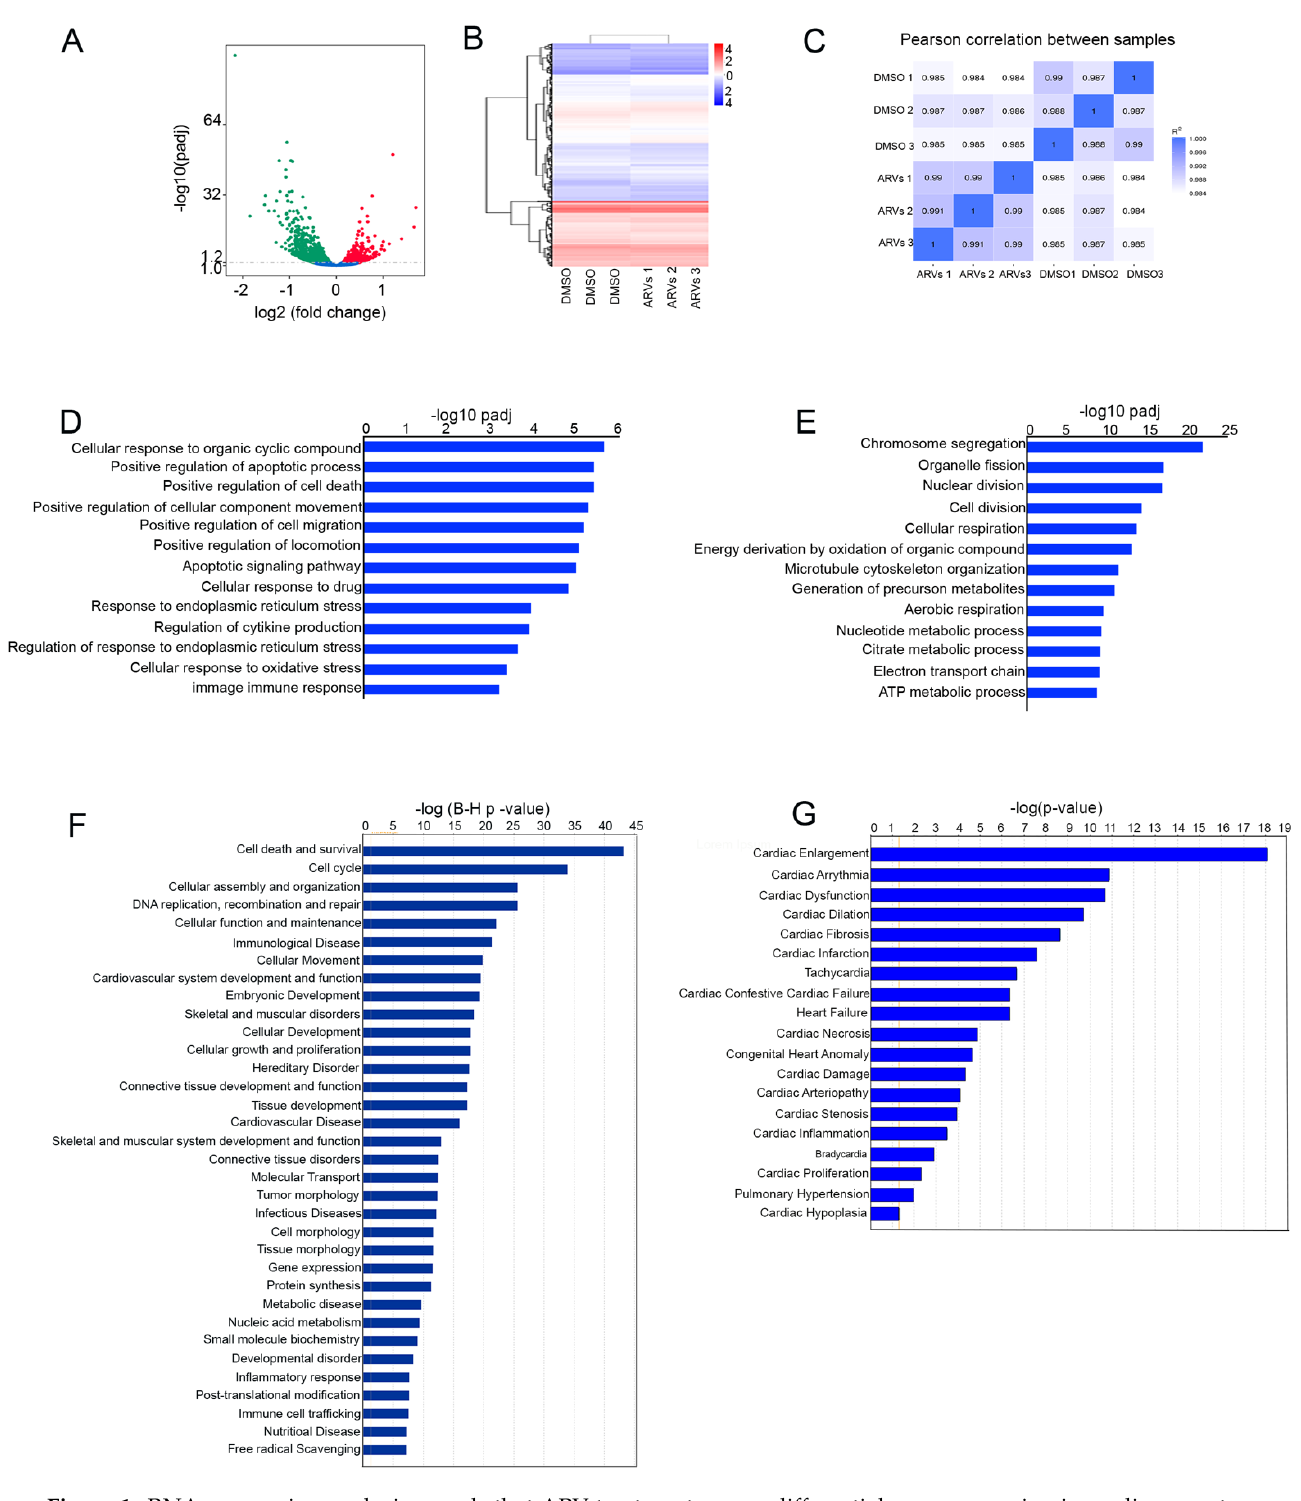
Figure 1. RNA sequencing analysis reveals that ARV treatment causes differential gene expression in cardiomyocytes. NRVCs were treated with a combination of ARVs (Ritonavir, Abacavir, Atazanavir Lamivudine (5 µM), and control cells were treated with DMSO for 24 h in groups of three replicates (n = 3), and total RNA sequencing was performed on the Illumina platform. ARVs treatment differentially regulates the expression of 1756 genes in cardiomyocytes. ( A ) Volcano plot shows differentially expressed genes (padj <0.05) using log2 (fold change) against-log10 (padi). ( B ) Hierarchical clustering and heatmap of differentially expressed genes show the expression level of genes in each replicate. Red color indicates genes with high expression levels, whereas blue color indicates genes with low expression levels. ( C ) Pearson correlation analysis between replicates shows a correlation coefficient between and among the replicates. The color from light to